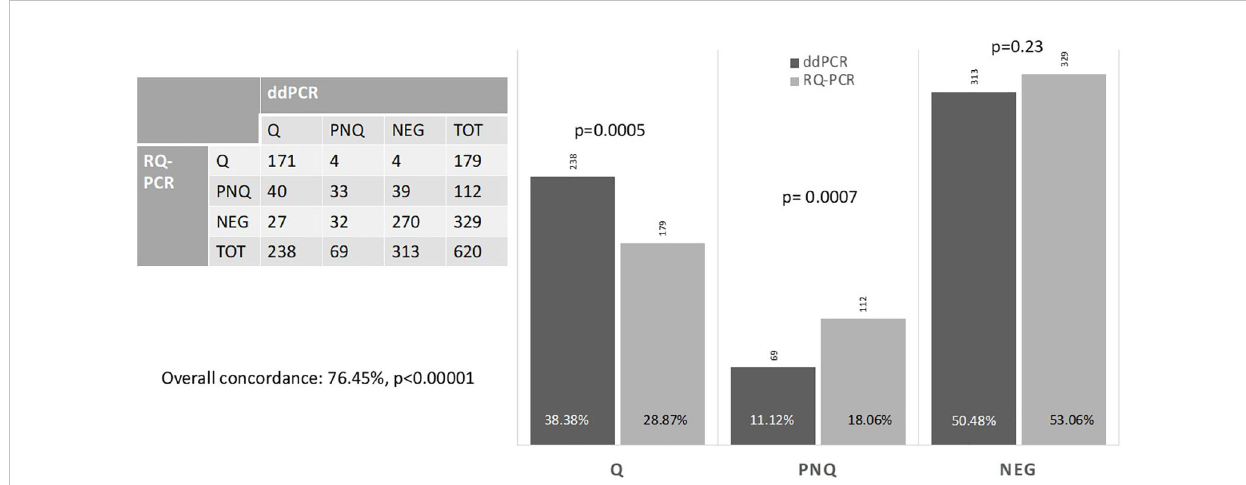
FIGURE 1 MRD comparison between ddPCR and RQ-PCR. At our Center, we evaluated 216 patients (113 ALL, 47 CLL, 48 FL, 8 MCL) at diagnosis and during the post-treatment follow-up, reaching a total number of 620 evaluations performed by both RQ-PCR and ddPCR, and distributed as follows: 326 ALL, 128 CLL, 142 FL, 24 MCL. The fi gure shows the overall concordance of the two methods and differences in de fi ning a sample as Quanti fi able (Q), Negative (NEG) or Positive Not-Quanti fi able (PNQ) for